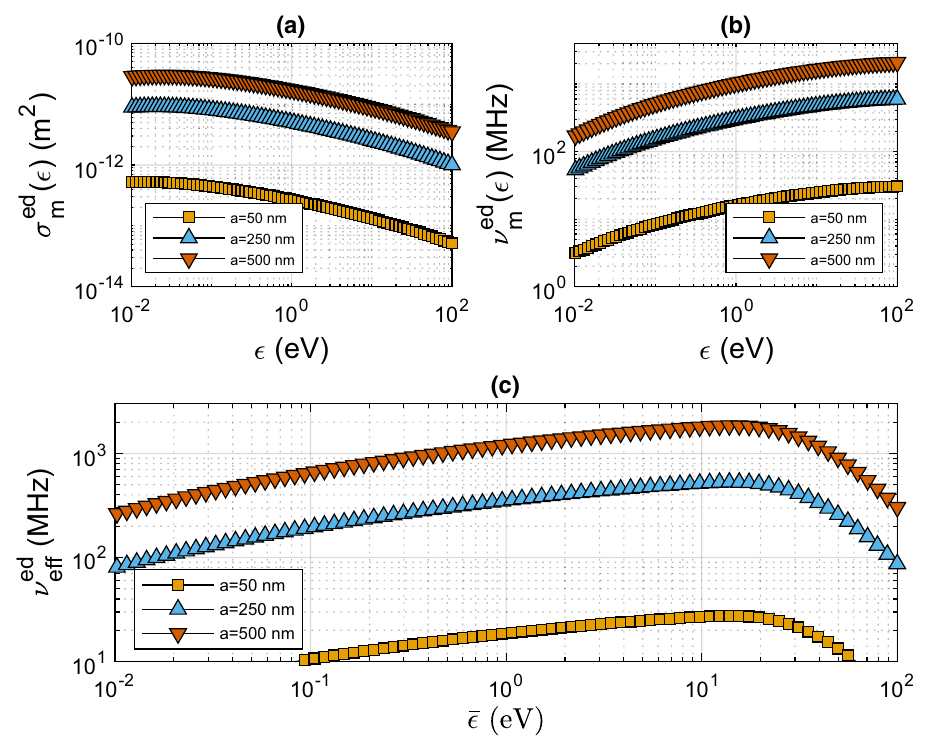
is m follows from the electron-dust momentum m for electron-dust collisions eff , ν ed , and ν ed is performed for m m eff